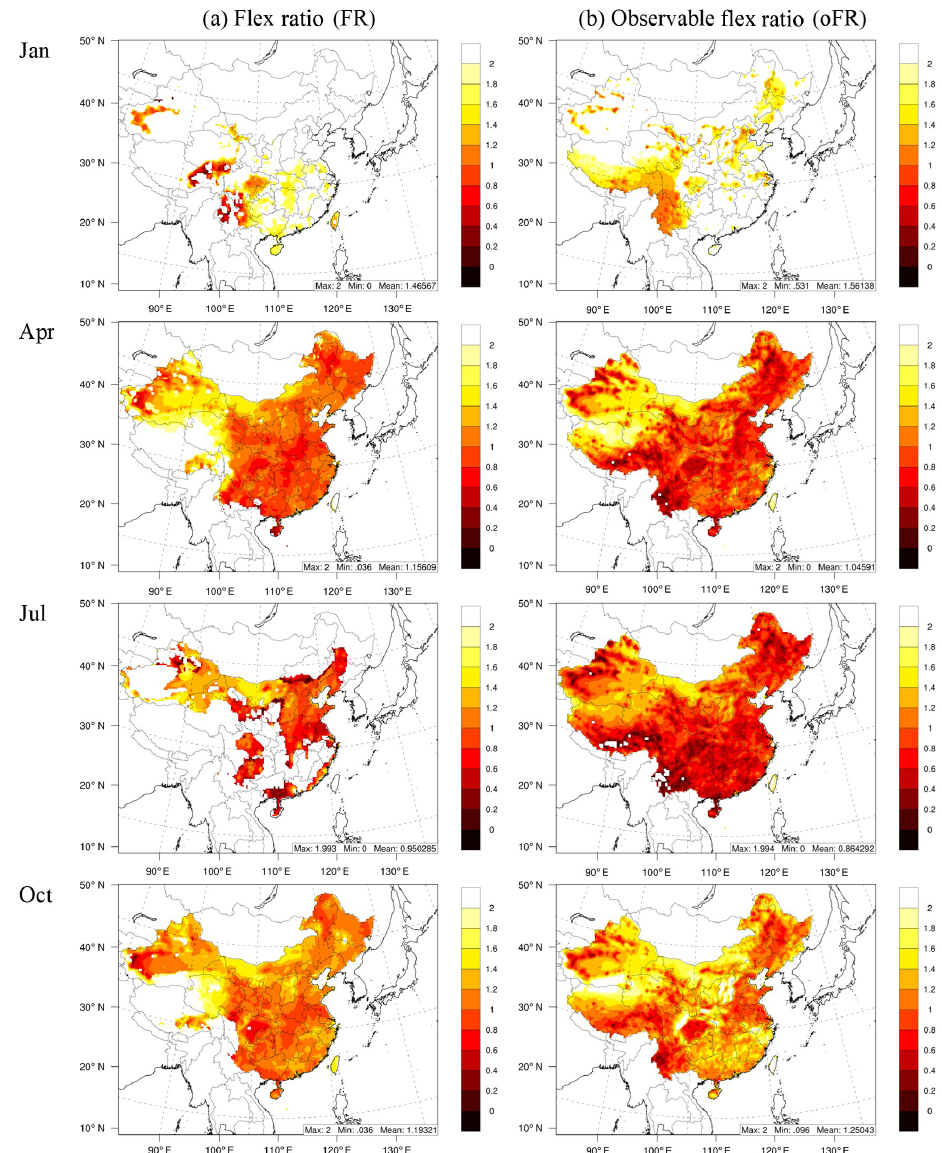
Figure 9. Comparison of the FR derived from the RSM with that calculated from concentrations for PM 2 . 5 chemistry. The oPR was estimated based on